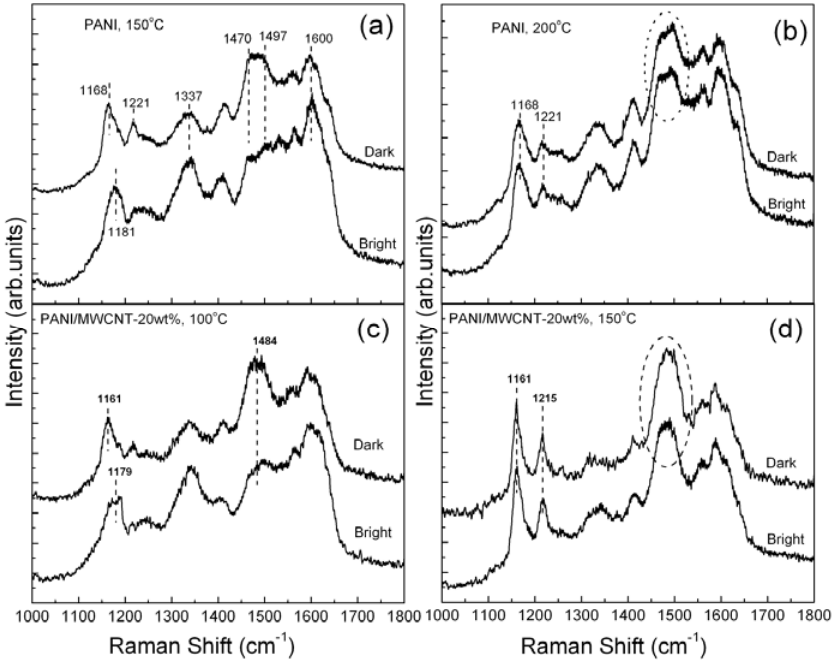
Figure 2. Raman spectra from the bright and dark region of nf-PANI after being baked in air at ( a ) 150 °C in air and ( b ) at 200 °C and those of nf-PANI/MWCNT-20wt% baked at ( c ) 100 °C and ( d ) 150 °C, respectively.